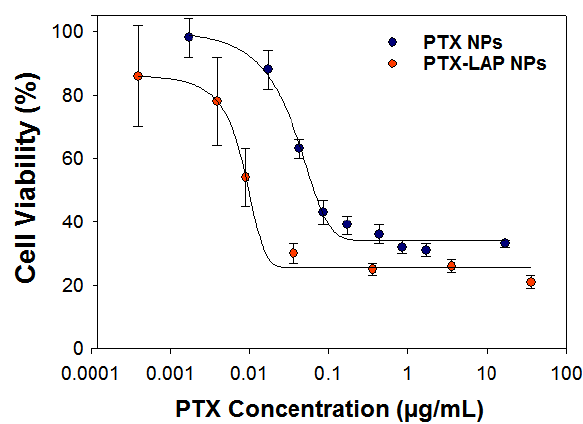
Figure 4. The cell viability dose–response curve of OVCA-432 cells when treated with (blue) paclitaxel nanoparticles (PTX NPs) and (red) paclitaxel–lapatinib nanoparticles (PTX–LAP NPs). The PTX–LAP NPs treatment shifts the dose–response curve to lower drug concentrations compared to the PTX NPs treatment. The graph shows the average ± standard deviation from one experiment performed with 6 replicate wells.